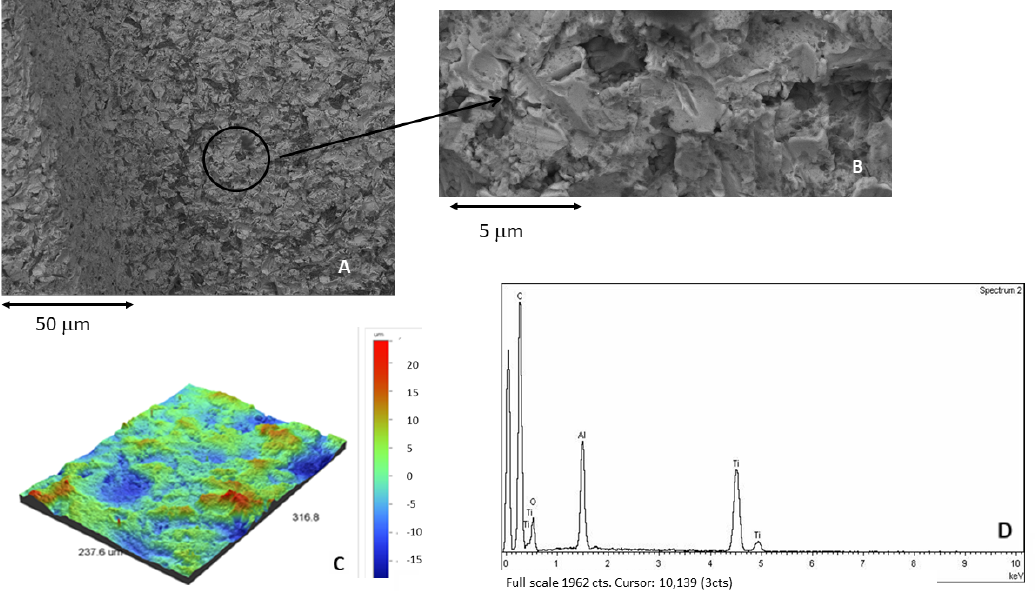
Figure 4. ( A ) Surface of the samples treated by sand blasting using alumina as abrasive. ( B ) At higher magnification. Presence of residual alumina on the surface. ( C ) Roughness in 3D image. ( D ) X-ray microanalysis showing the presence of aluminum.